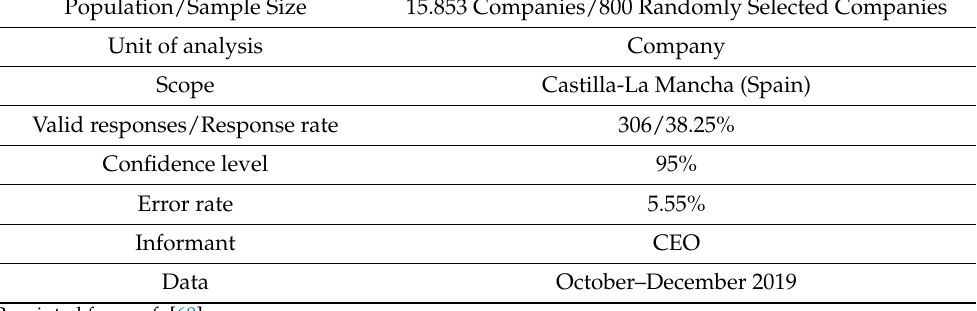
Table 1. Research technical data. Population/Sample Size